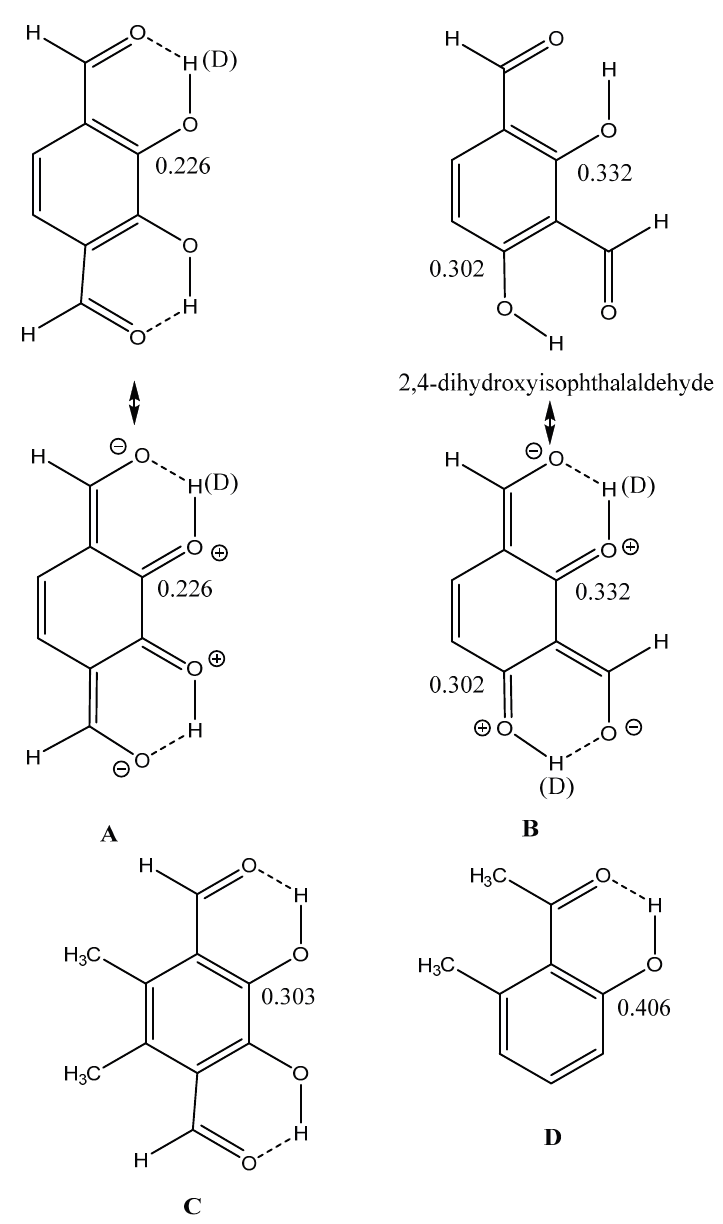
Figure 7. Aldehydes. Data for D taken from Ref.